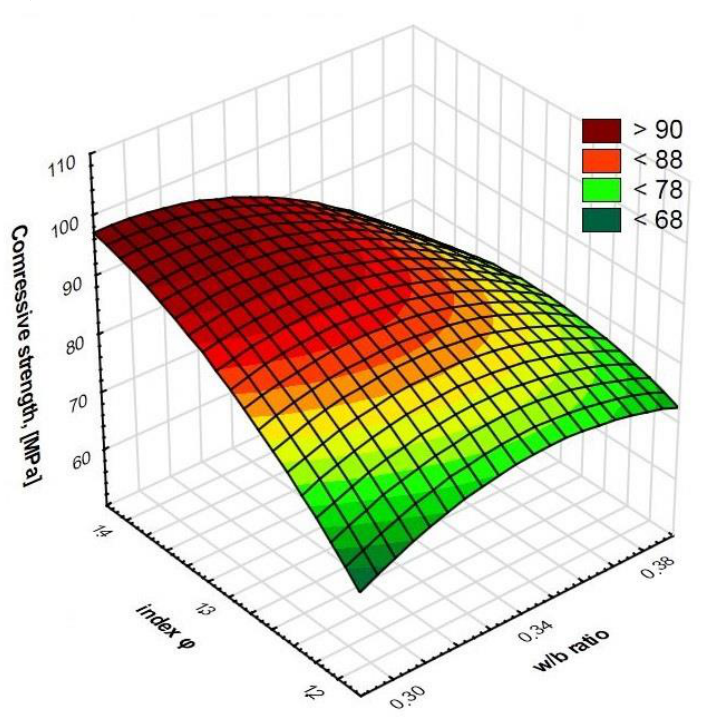
Figure 6. Surface chart. Relationship between w/b ratio and index φ on compressive strength. R 2 = 0.98.